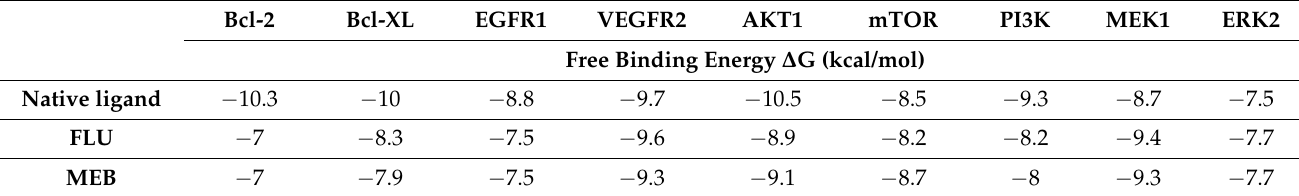
Table 2. Docking results (binding energy, ∆ G kcal/mol) for compounds MEB and FLU.